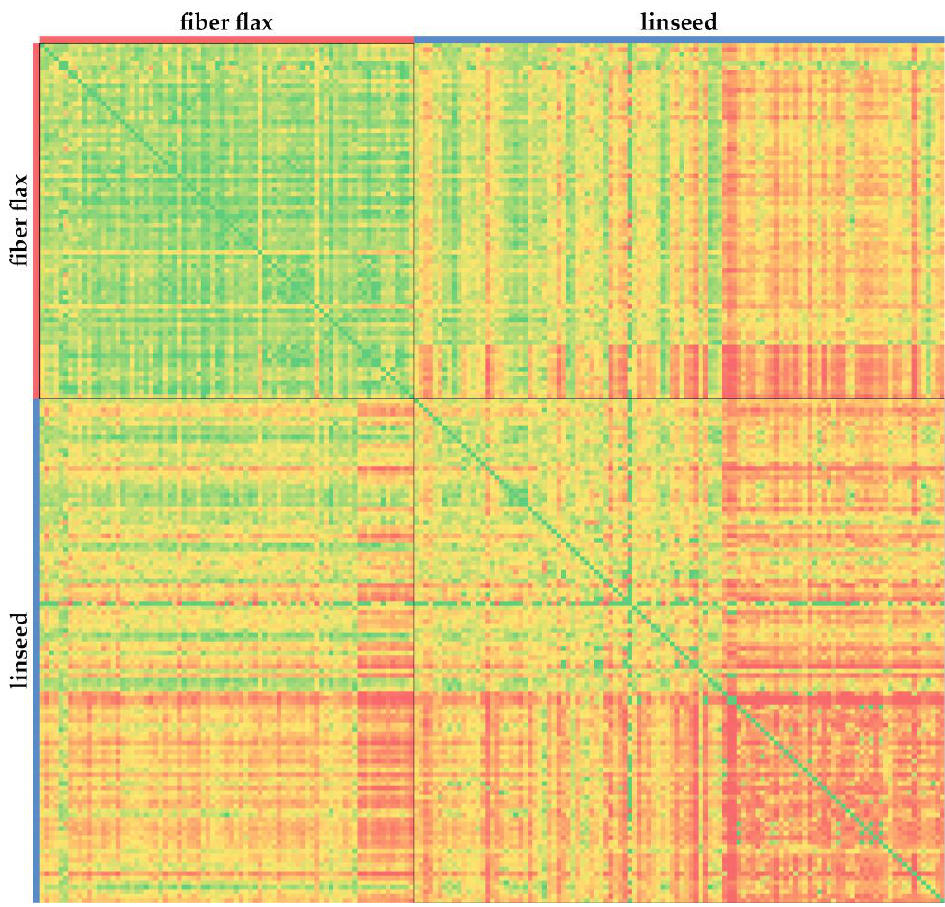
Figure 2. Genetic similarity between fiber flax and linseed varieties based on polymorphisms in the studied genes of the 4CL , C 3′ H , C4H , CAD , CCR , CCoAOMT , COMT , F5H , HCT , PAL , CTL , BGAL , ABC , HMA , DIR , PLR , UGT , TUB , CESA , RGL , FAD , SAD , and ACT families. The green–yellow–red color scale indicates the level of genetic similarity between varieties, from the highest (green) to the lowest (red).